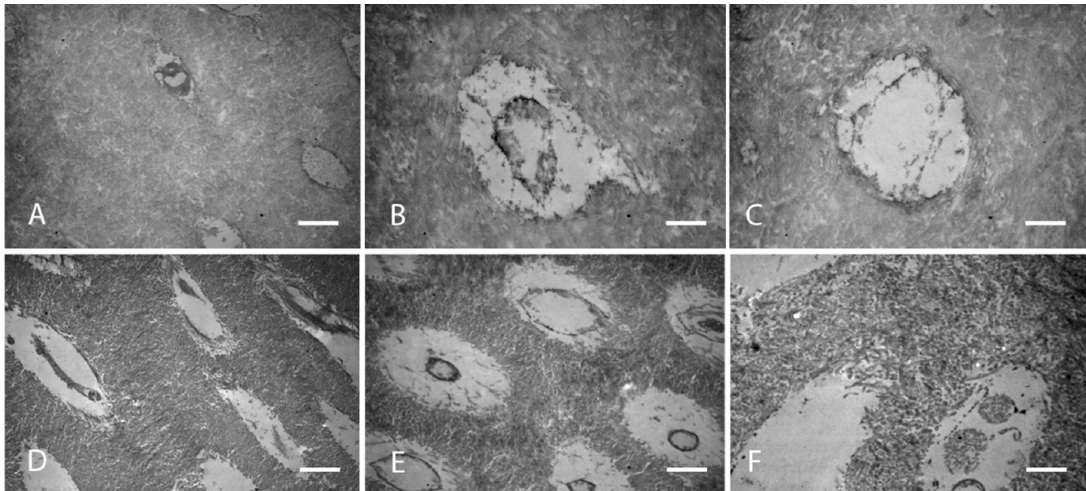
Figure 4. TEM analysis of dentin from healthy and OI donors. ( A – C ): Compacted collagen with a fibrillar scaffold and regular odontoblastic process in healthy donors; ( D ): Absence of odontoblastic process in dentin tubules in OI patients; ( E , F ): Unusual collagen circles with unorganized and unpacked collagen in OI patients.